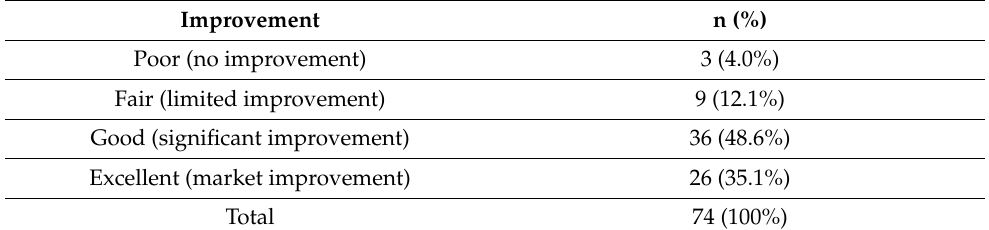
Table 4. Improvement of periorbital hyperpigmentation aspect according to patient’s